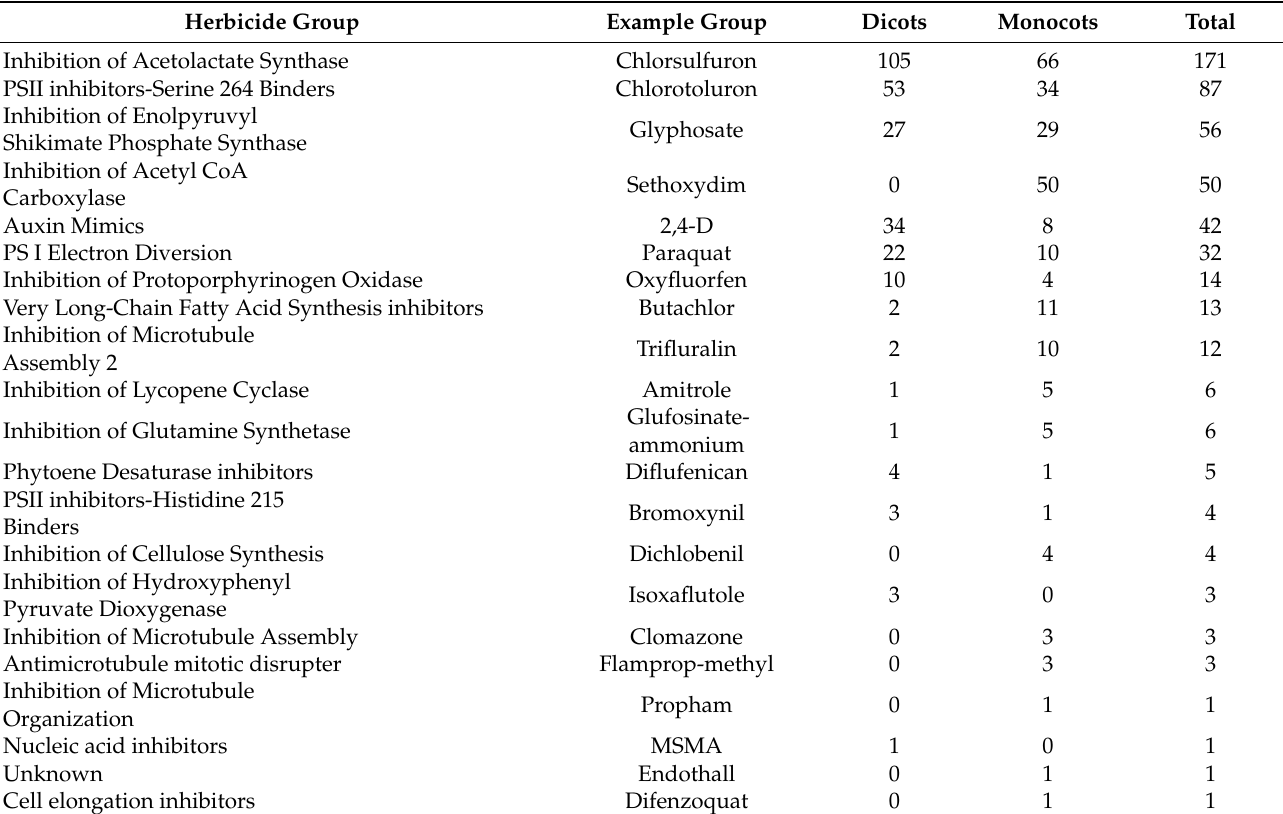
Table 1. Major herbicide targets and the number of herbicide-resistant weeds by site of action (including cross-resistant